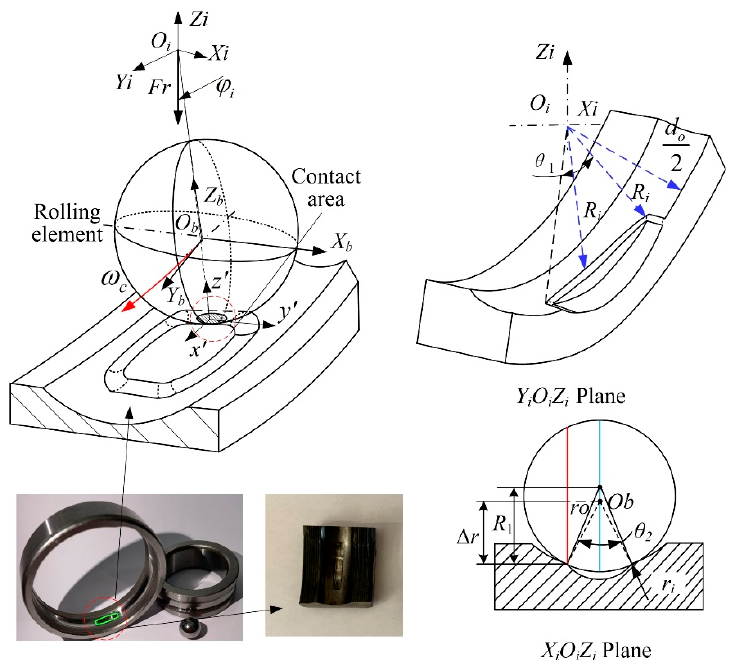
Figure 1. Structural model of cageless bearing with variable diameter raceway.